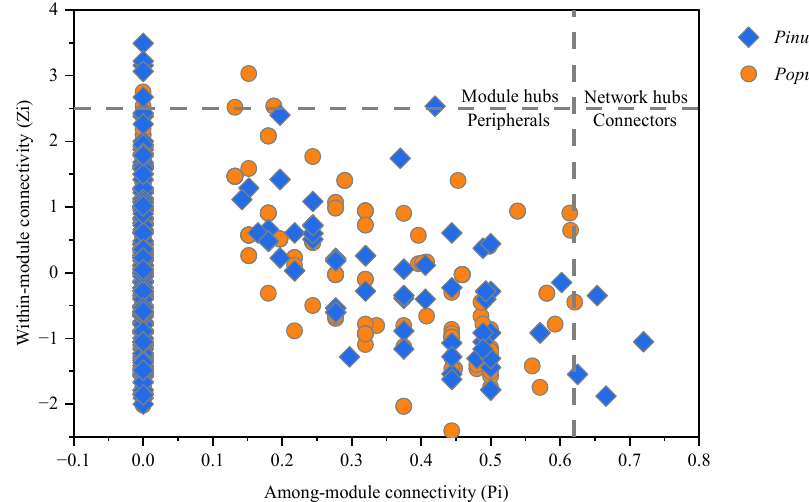
Figure 6. Z-P plot of soil bacterial molecular ecological networks under the reclamation of P. tabu- laeformis and P.